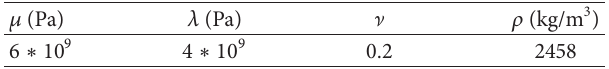
Table 2: Material data for elastic